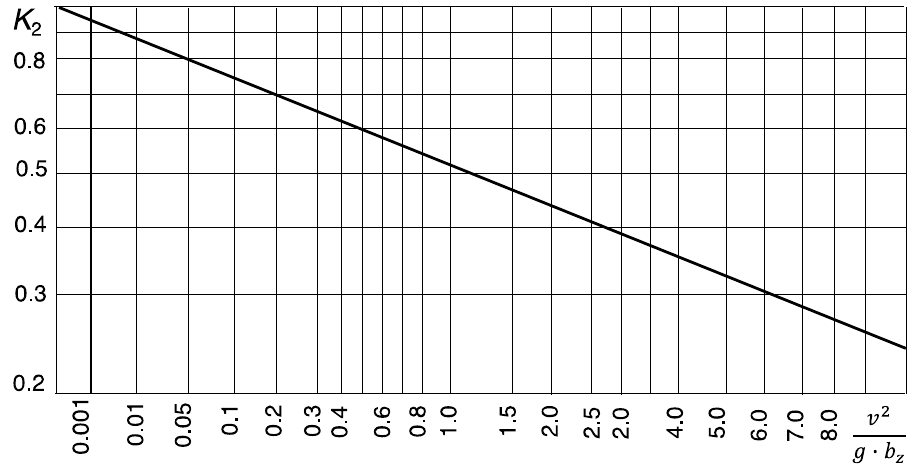
Figure 8. Coefficient K 2 (in accordance with Journal of Laws of 2000 No. 63, item 735 [11]).